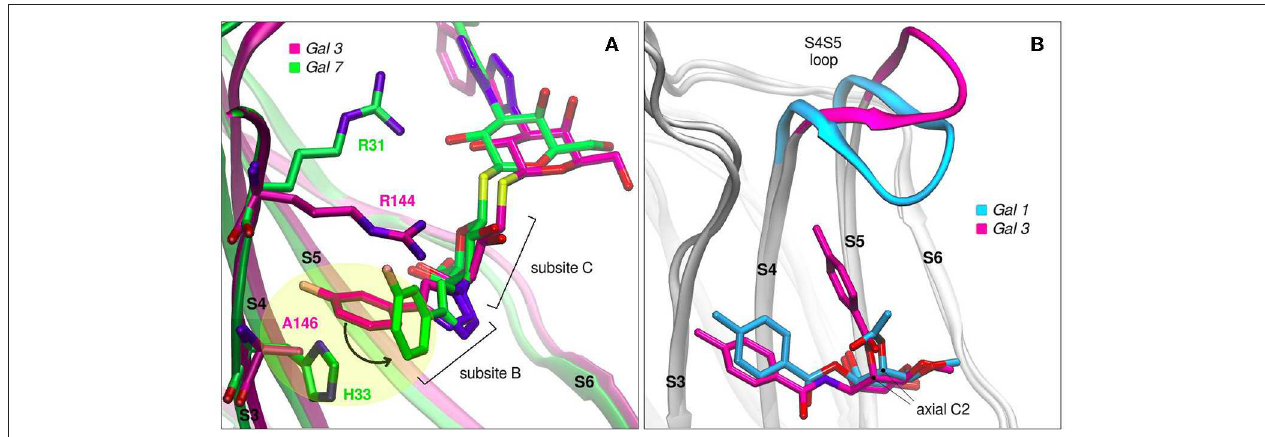
FIGURE 8 | Galectins in complex with carbohydrate-derived monovalent inhibitors. (A) Thiodigalactoside “TD139” superimposed complexes of Gal-3 (magenta, PDB id: 5h9p) and Gal-7 (green, PDB id: 5h9q) (B) Taloside inhibitors superimposed complexes. Gal-1 and methyl 2-O-acetyl-3-O-toluoyl-beta-D-talopyranoside (cyan, PDB id: 3T2T), Gal-3 and methyl 3-deoxy-2-O-toluoyl-3-N-toluoyl-beta-D-talopyranoside (magenta, PDB id: